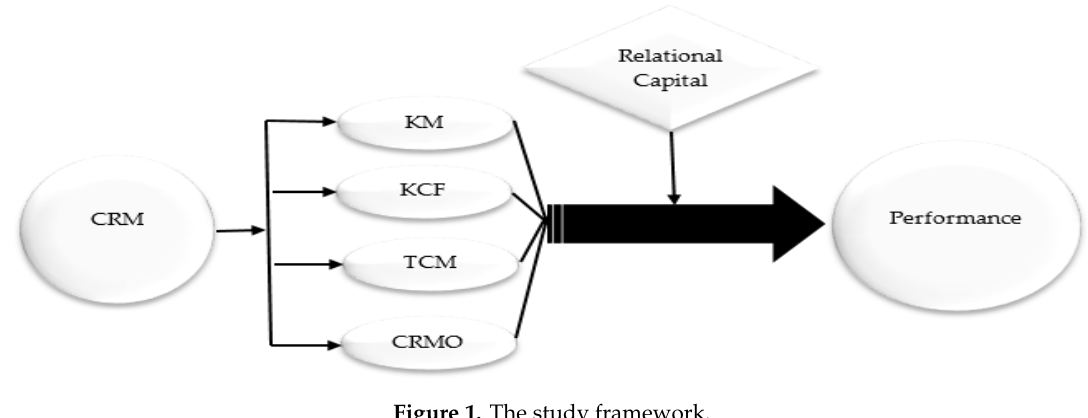
Figure 1. The study framework.